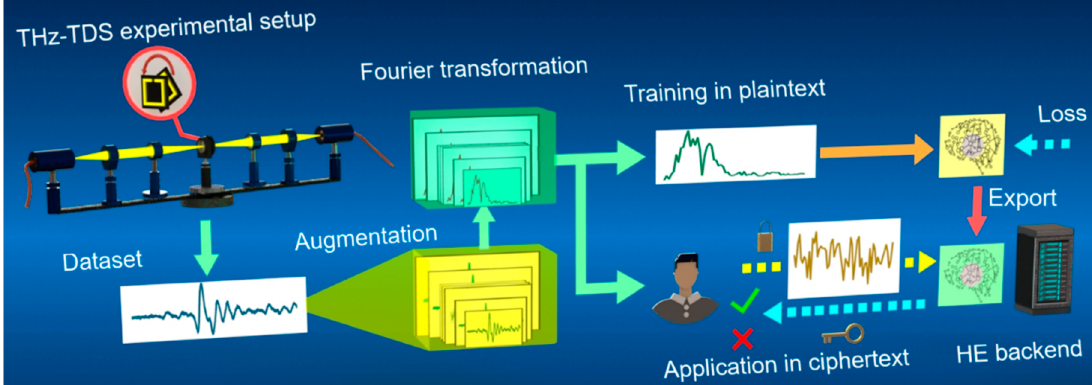
Figure 1. The workflow of private preserving terahertz (THz) metamaterial identification. Photocurrent signals of samples were obtained from THz measurement system and then transformed to frequency-domain. The training stage in plaintext and the application stage in ciphertext are illustrated in the upper right and lower right parts, respectively.